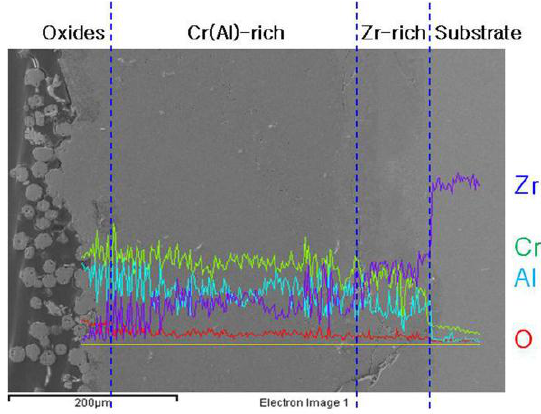
Figure 5. SEM-EDS analyses of CrAl coating layer on Zircaloy-4 alloy after the isothermal heating at 1100 °C for 2 h in inert atmosphere.